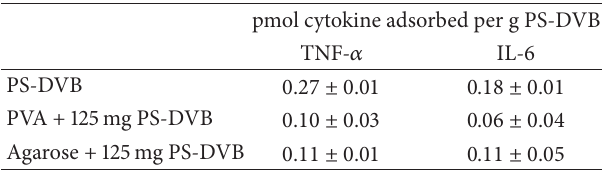
Table 4: Adsorption of TNF- 𝛼 and IL-6 on PS-DVB microparticles and composite cryogels after 60 min under static conditions ( 𝑛 = 3